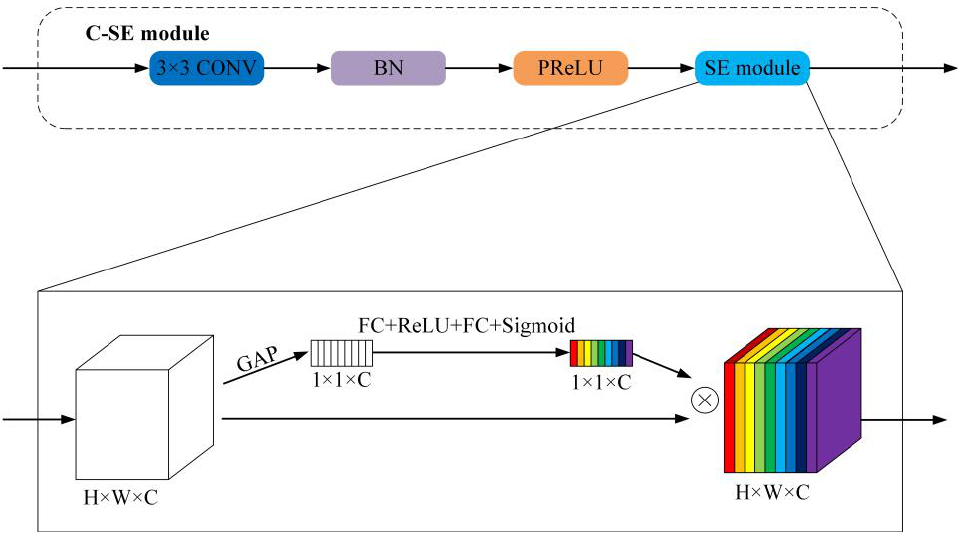
Figure 4. Structure of the C-SE module.